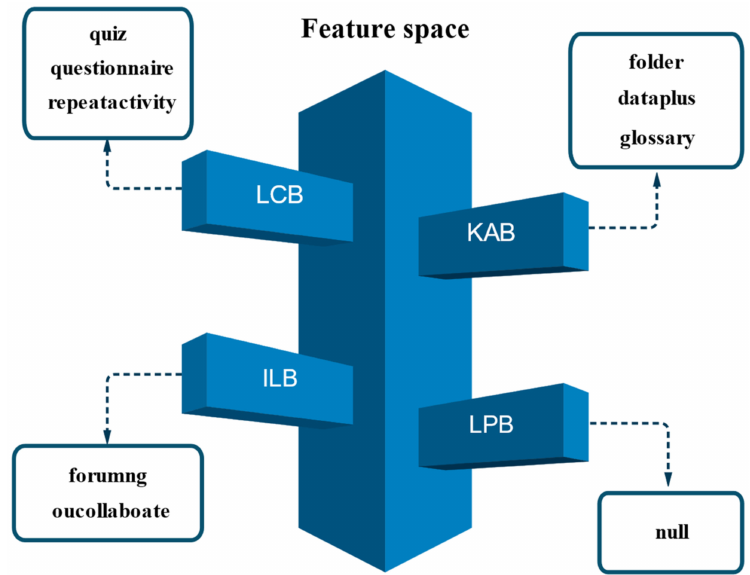
Figure 3. Schematic diagram of e-learning behavior classification in feature